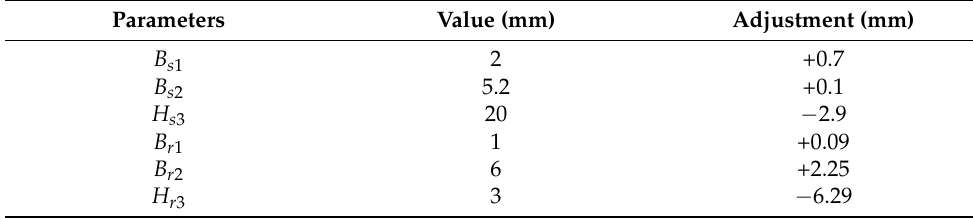
Table 8. Optimal setting of stator and rotor slots.